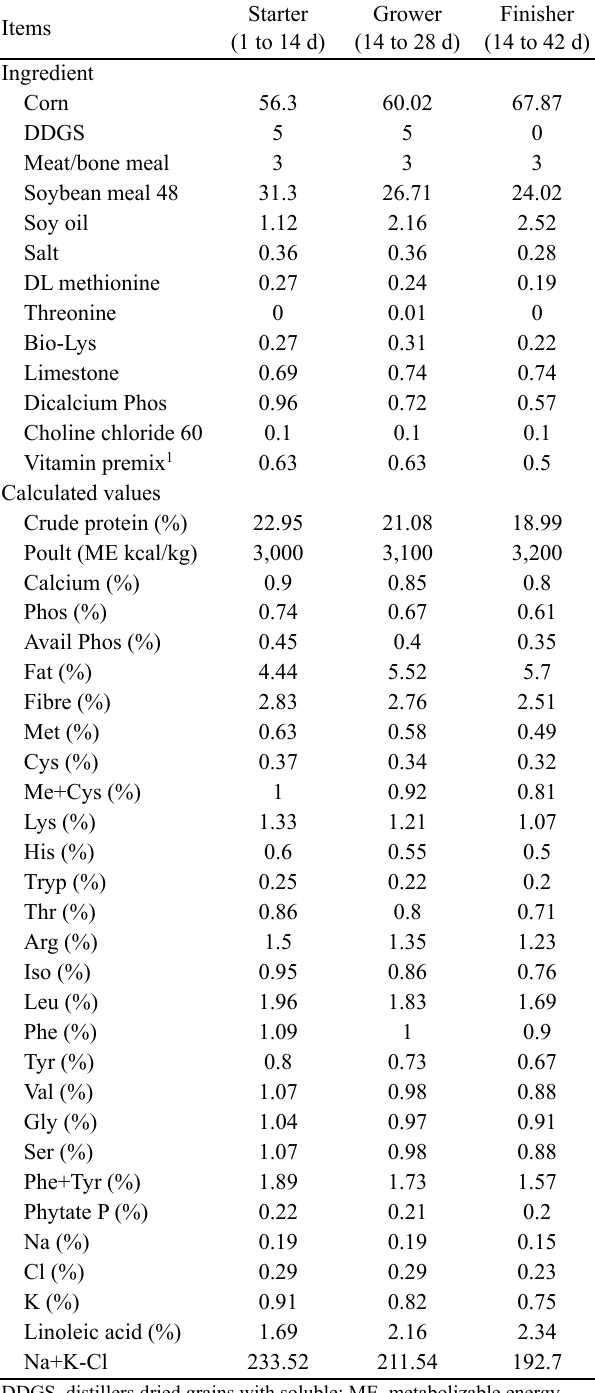
Table 1. Composition of the basal (control) diet (%)